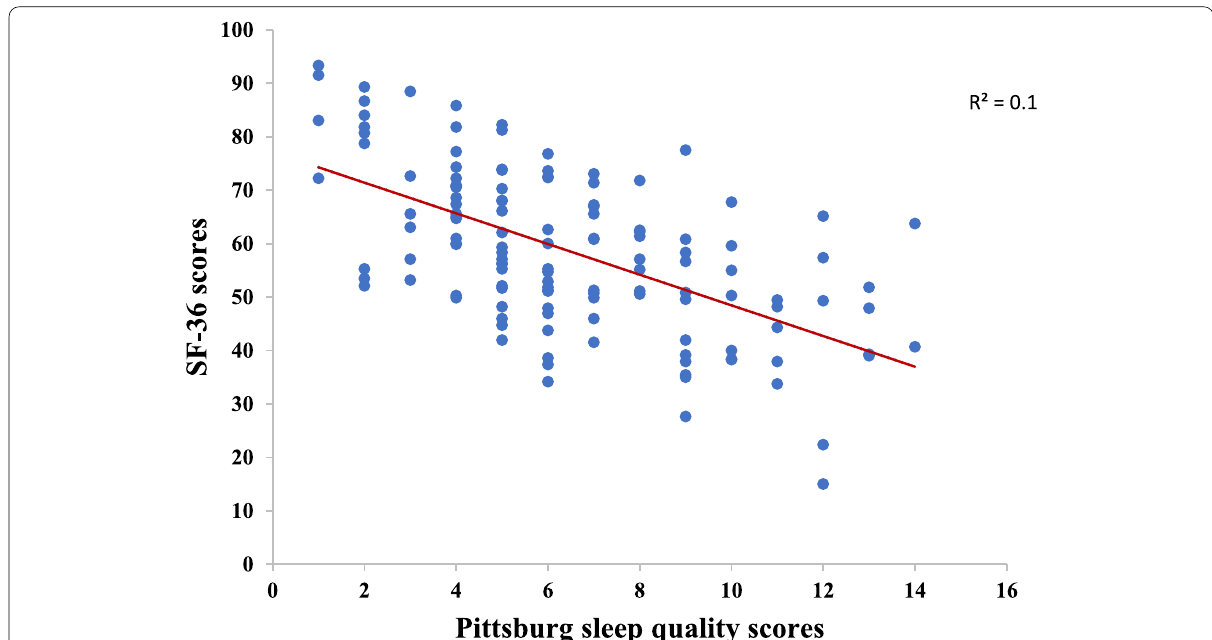
Fig. 3 Correlation between global PSQI scores and total quality of life scores in the studied population